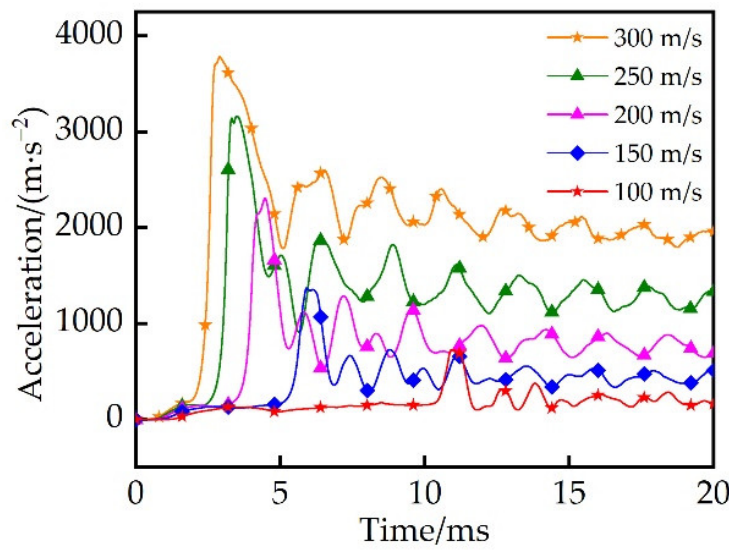
Figure 17. Time–history of acceleration at different speeds of water entry.